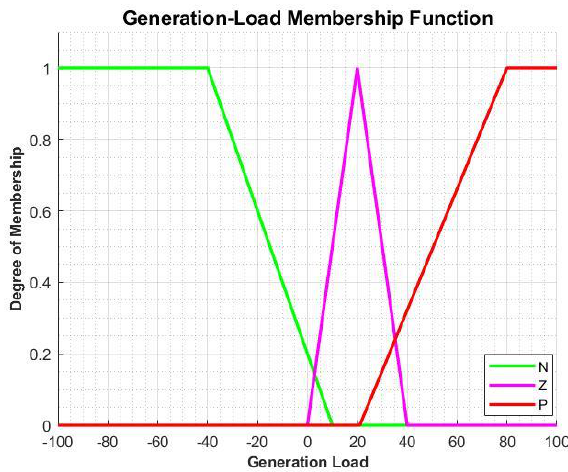
Figure 7. Fuzzy membership functions for excess power .